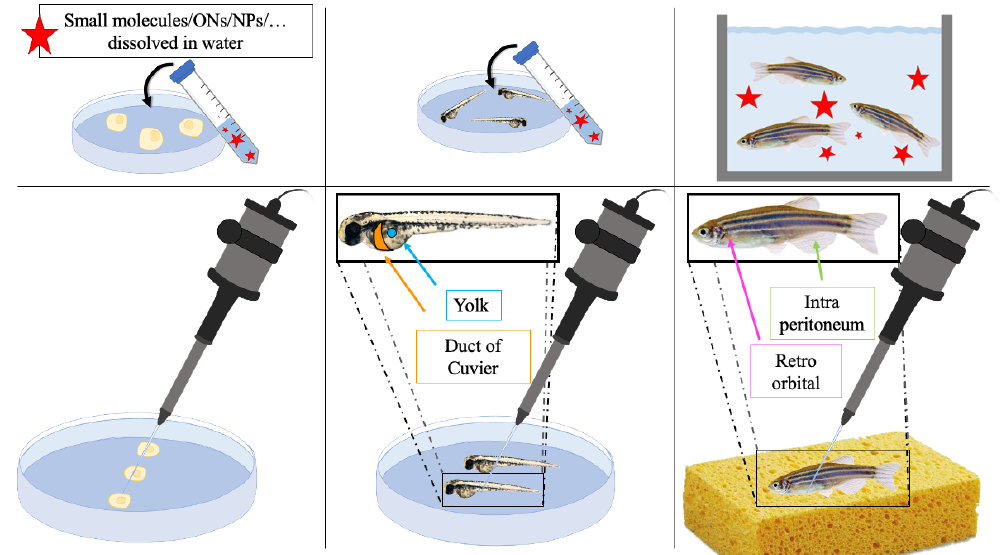
Figure 7. Schematic representation of different strategies to administer therapeutic compounds. ONs: oligonucleotides; NPs: nanoparticles.